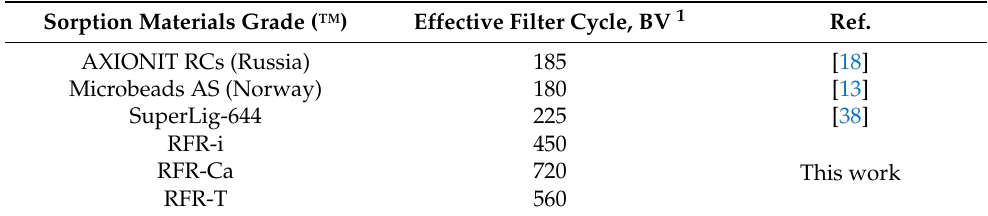
Table 4. Comparative characteristics of sorption materials for cesium removal from the clarified LRW fraction under dynamic conditions.